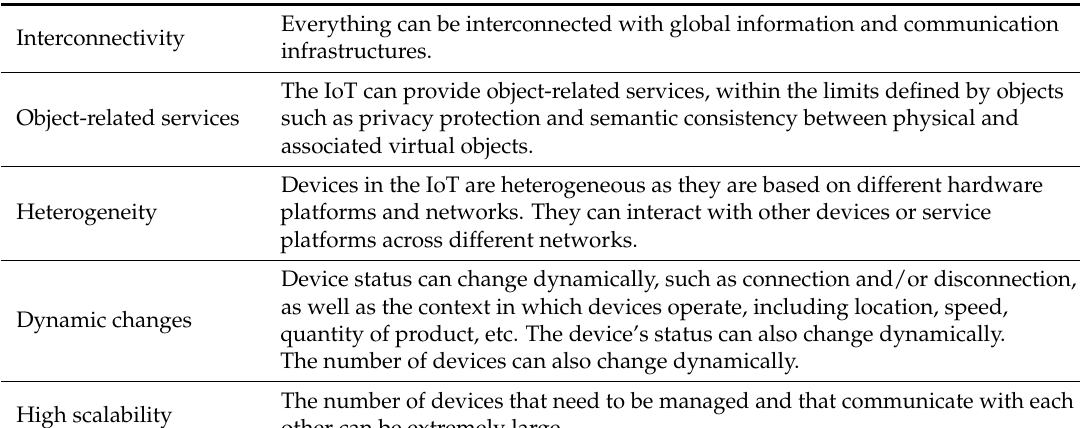
Table 1. Key features of the IoT.